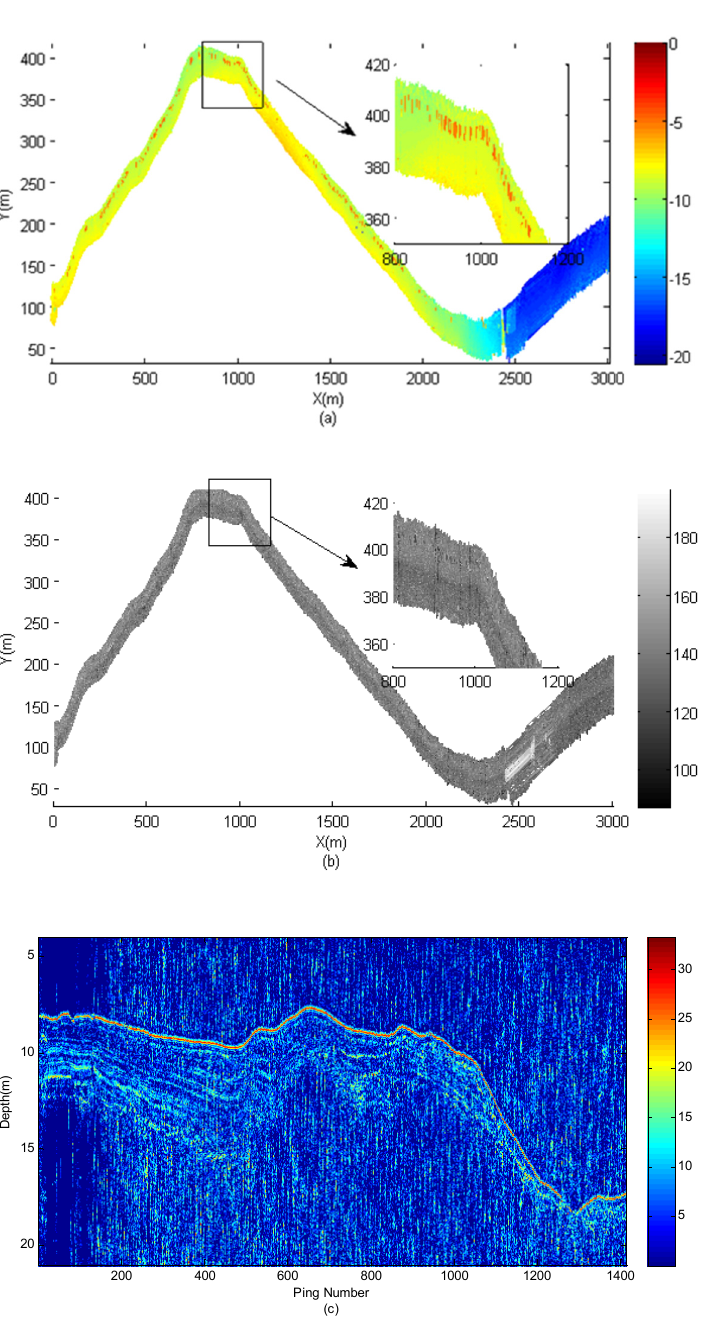
Figure 12. Seabed detection results in integrated detection mode. ( a ) Topography results; ( b ) sediment geomorphology results; ( c ) sub-bottom profiling results.